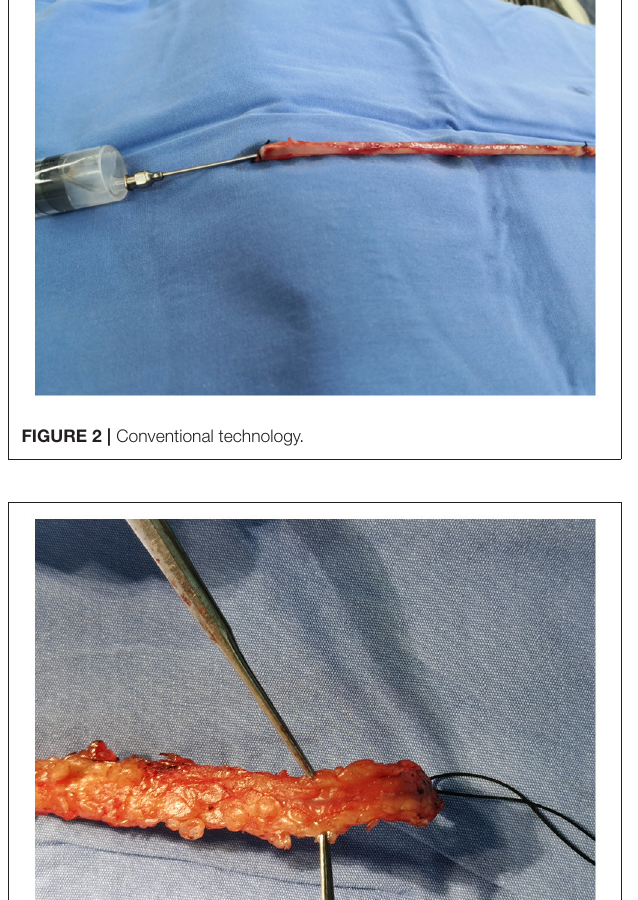
in Figure 4 ; after matching: sequential vein grafting, NT: